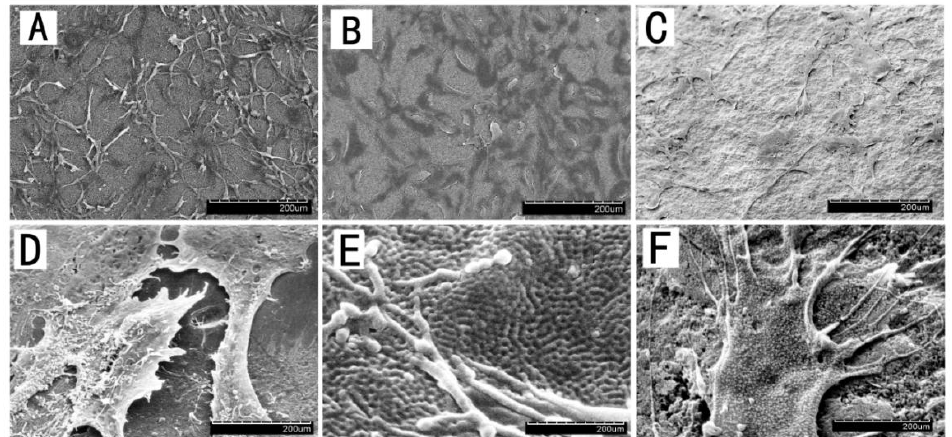
Figure 4. SEM micrographs showing osteoblast filopodia growth on ( A ) Cp–Ti, ( B ) TNT, and ( C ) HA/Gentamicin/TNT substrates after 72 h. Greater SEM micrographs magnification of osteoblasts on ( D ) Cp–Ti, ( E ) TNT, and ( F ) HA/Gentamicin/TNT surfaces revealed a far more prominent filopodia protrusion, a more extended structure, and an elevated level of contact with the TNT and HA/Gentamicin/TNT when contrasted with those on the Cp–Ti substrate.